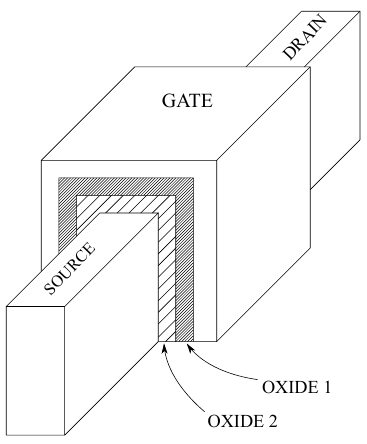
Figure 9. 3D double hetero gate oxide FinFET